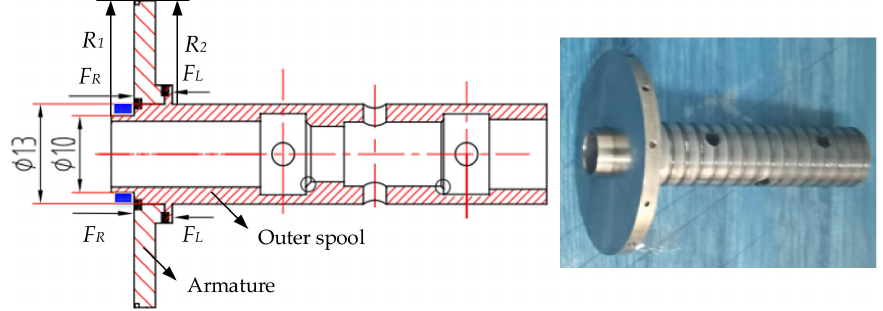
Figure 6. Solenoid valve moving